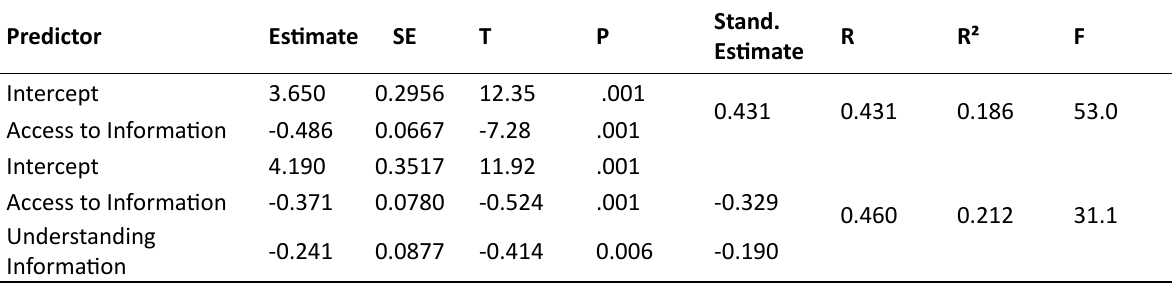
Table 3. Regression Analysis Results Related to the Prediction of Health Literacy Sub-Dimensions for Coronavirus Anxiety Level Predictor